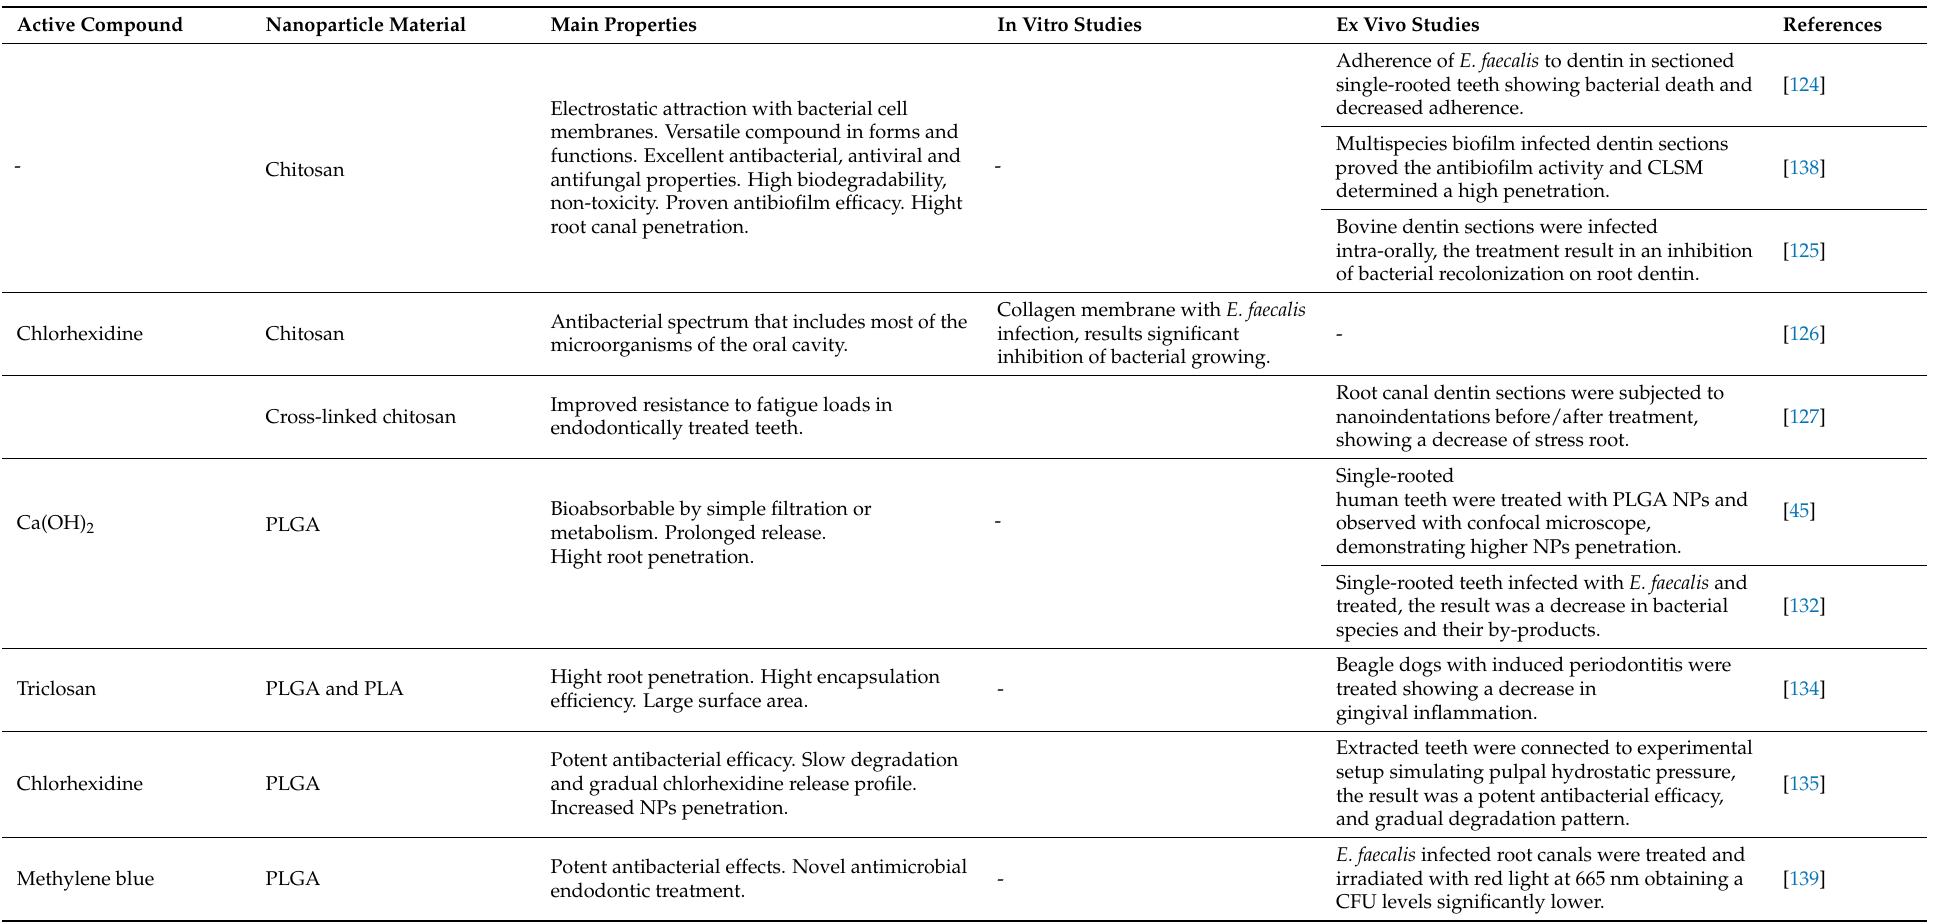
Table 3. Summary of biodegradable NPs used in endodontics